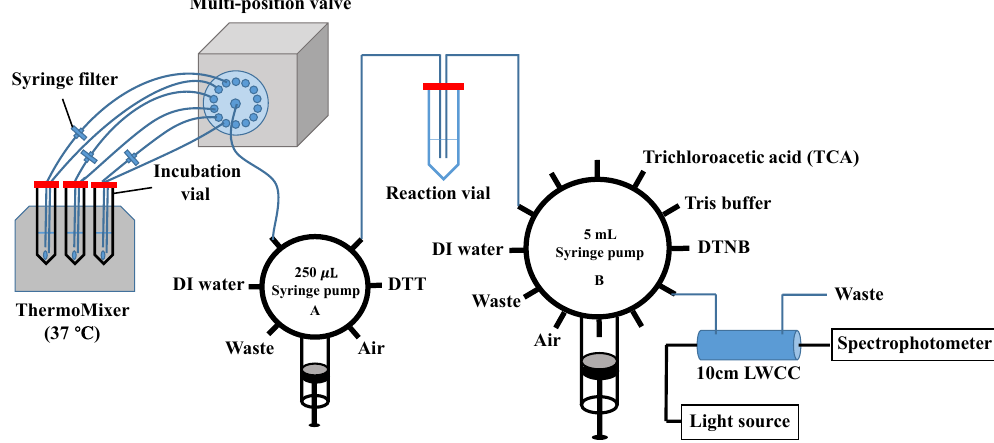
Figure 2. Automated system setup for measuring OP DTT-Total . The assay is performed in the vial containing the filter sample and extraction water, which had been sonicated. The assay is filtered just prior to analysis in the liquid wave guide capillary cell